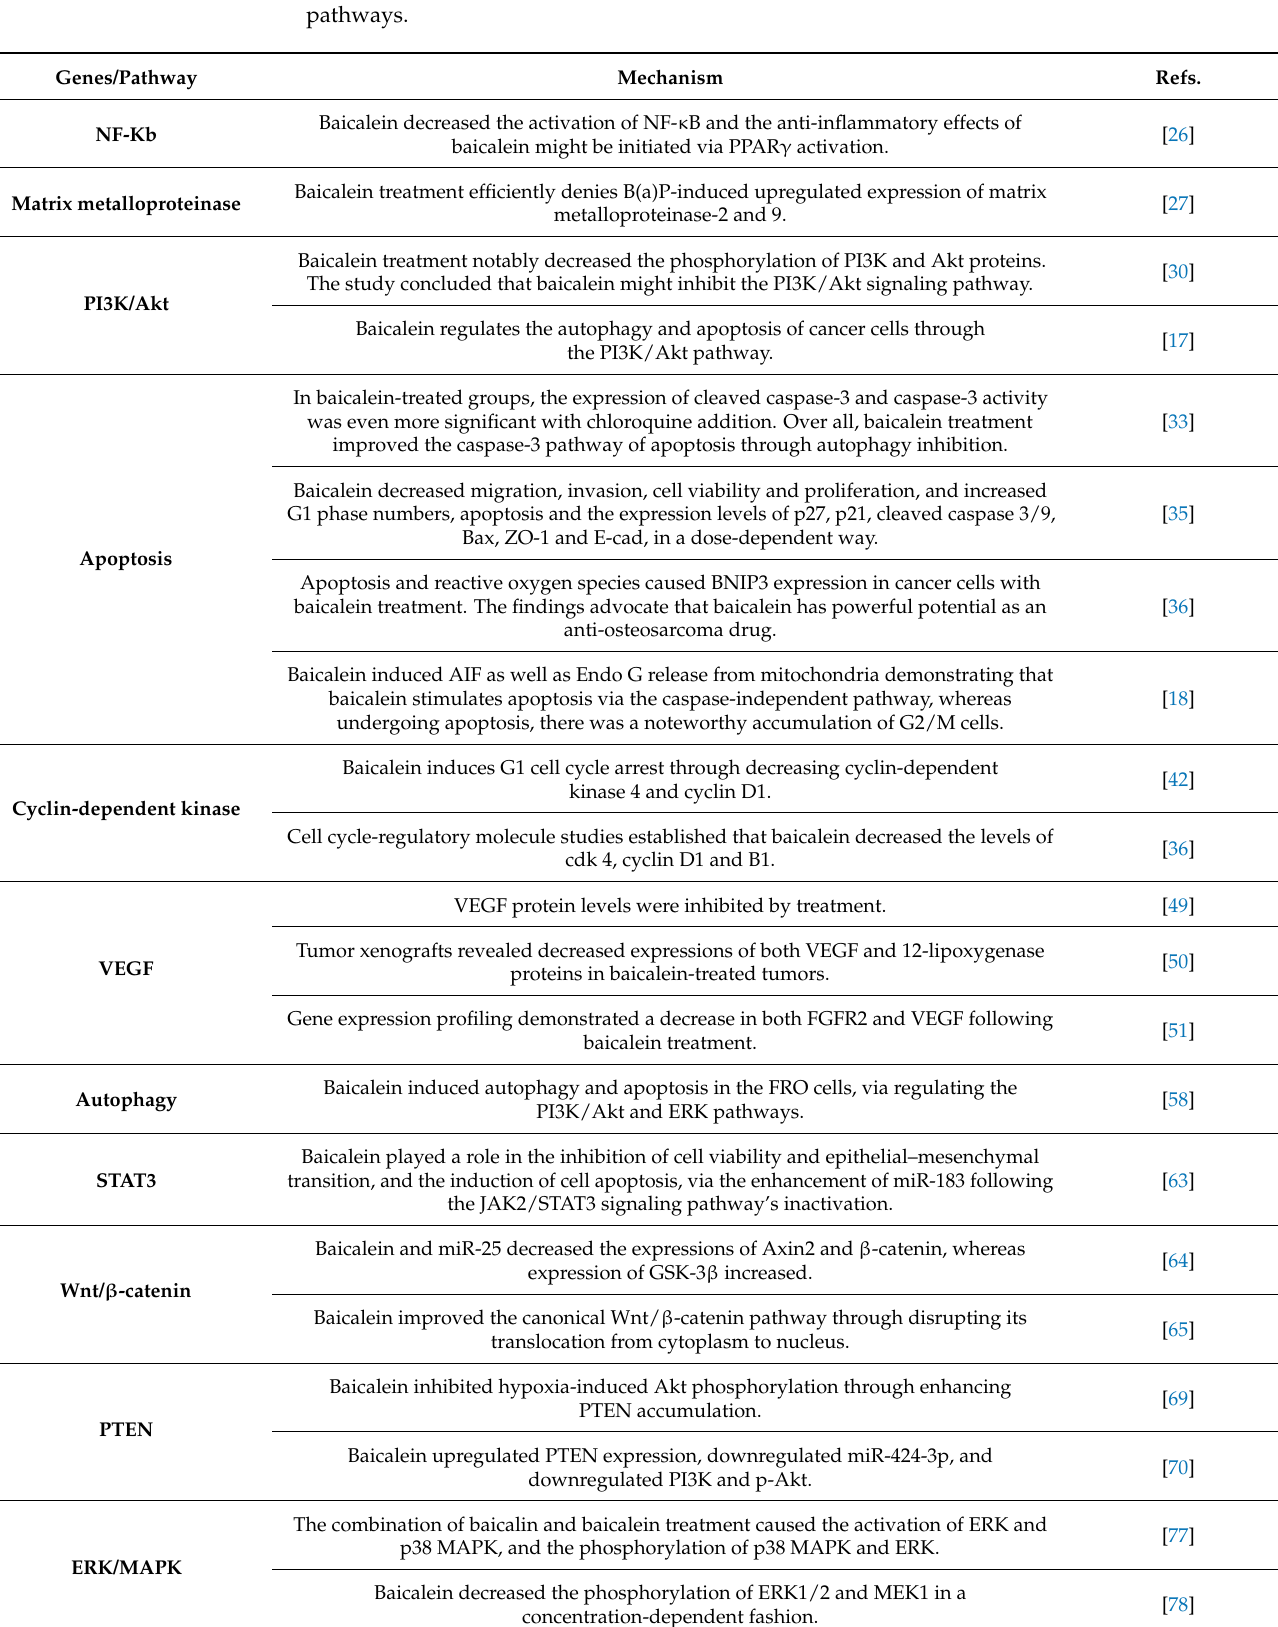
Table 1. Key mechanism of baicalein in tumor management through the enhancement of cell signaling